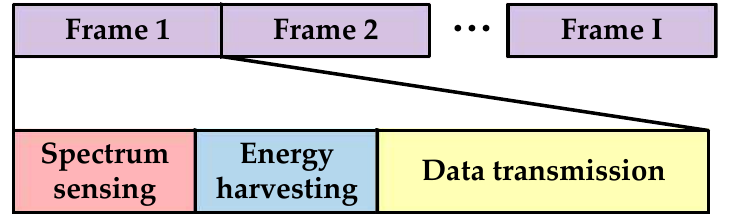
Figure 2. Frame structure of the single cognitive